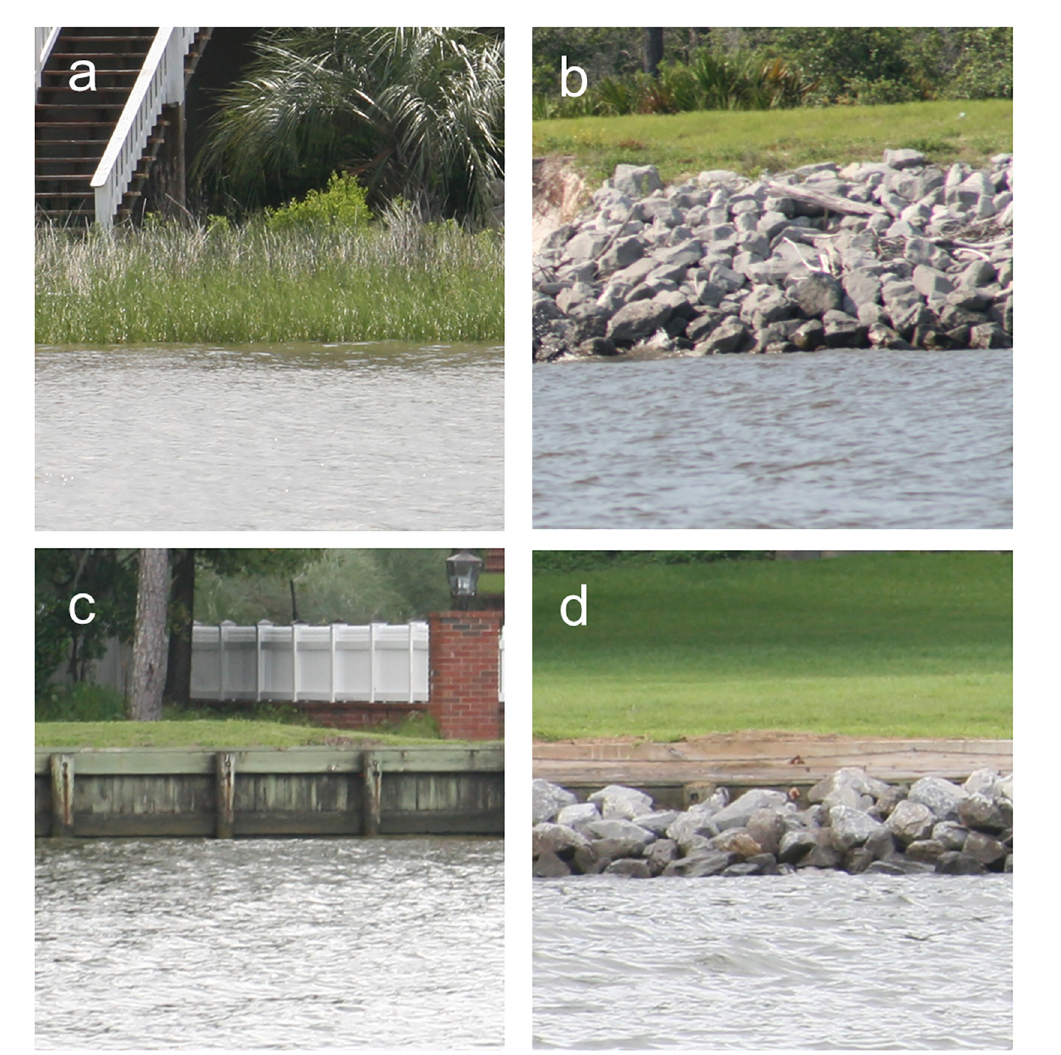
Fig 1. Example photographs of shoreline types. Photographs of (a) natural, (b) riprap / rubble, (c) vertical wall and (d) vertical wall with riprap shorelines in the study system.